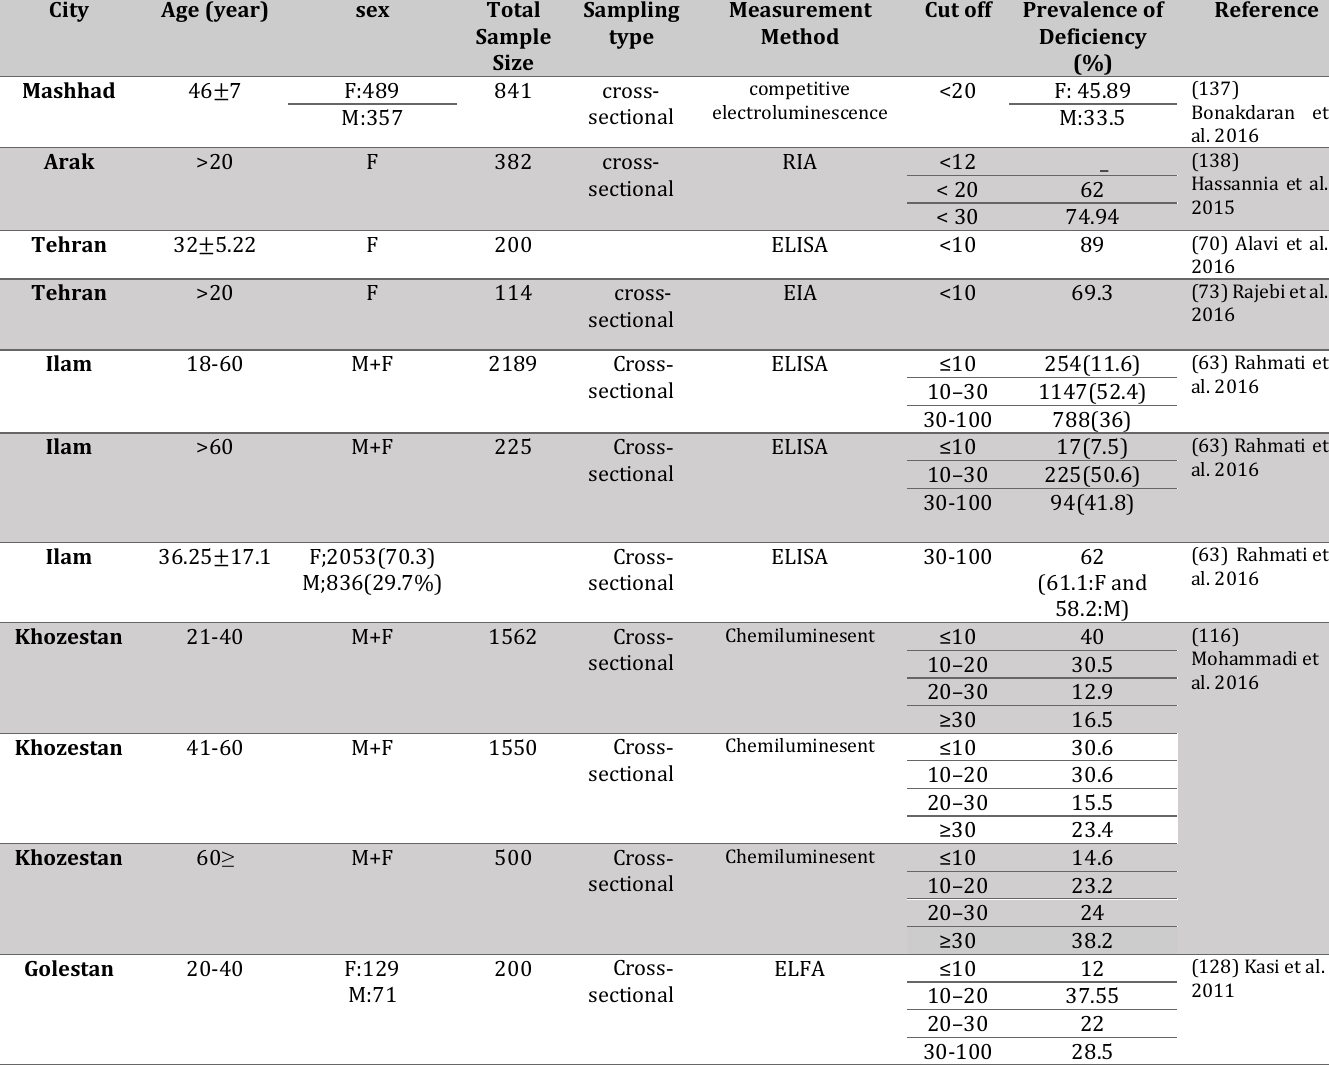
Continue Table 4. Characteristic and main results for the prevalence of vitamin D deficiency or insufficiency in Iranian children, adolescents, adults and